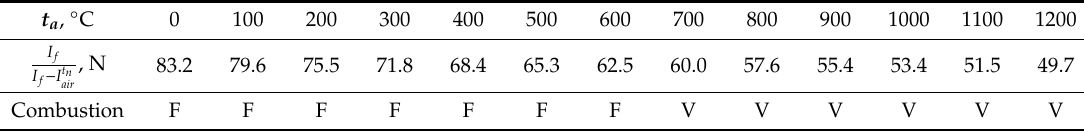
Table 7. Influence of the amount of air heating in regenerators on the organization of volume fuel combustion; F—flame,